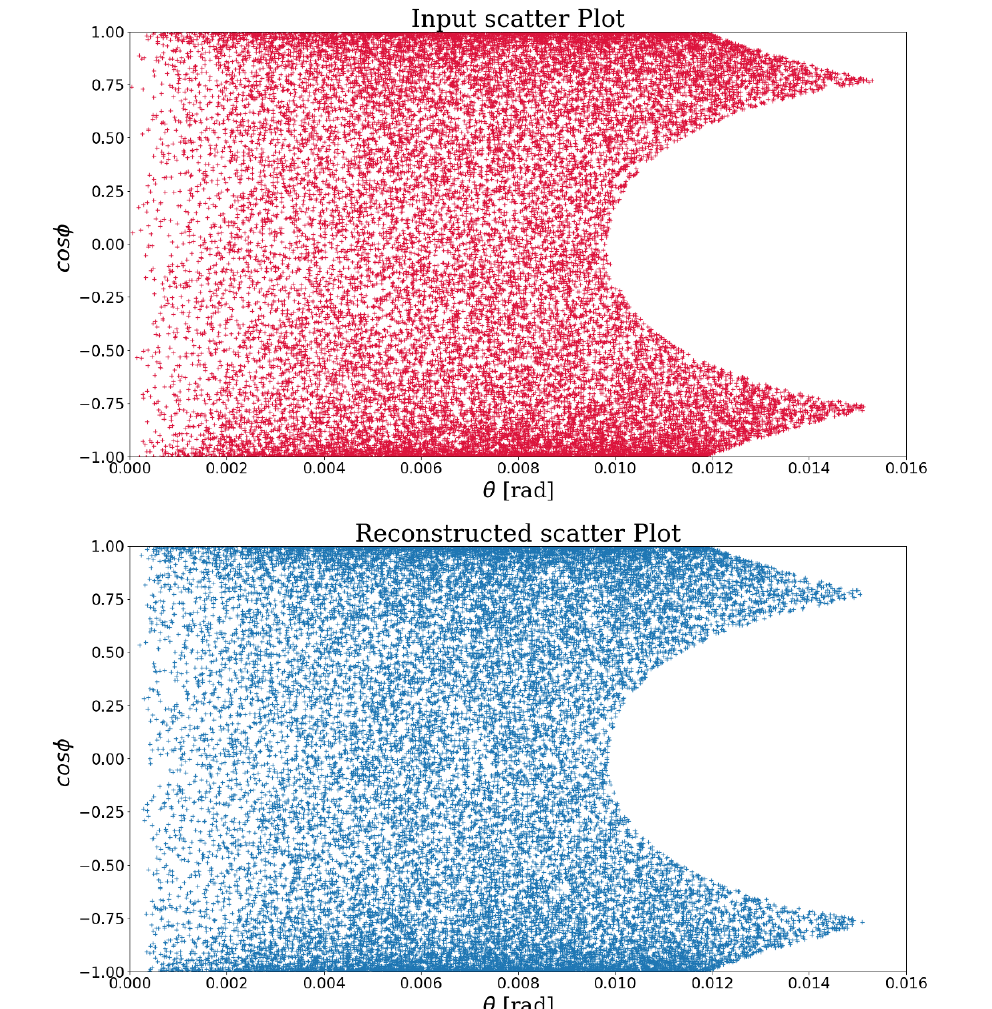
Figure 6. Comparison plot between the (cid:18) (cid:0) (cid:30) correlation as given by the original input scatter data (top panel) and by the re-generated points (bottom panel) obtained according to the procedure outlined in the main